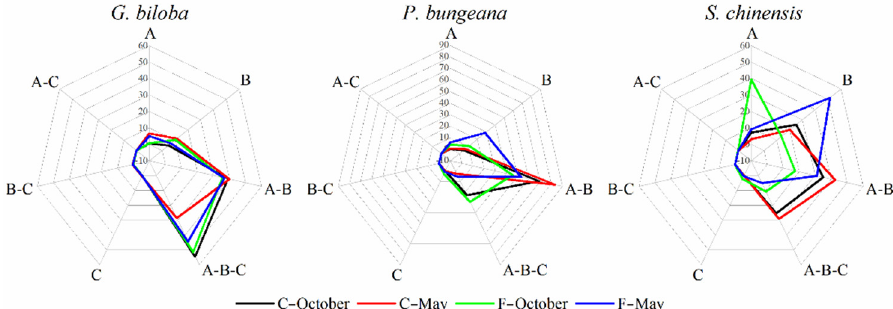
Figure 4. Changes in fungal metabolic function attributes of G. biloba , P. bungeana and S. chinensis in October and May. Letters A, B and C represent the functional attributes of pathotrophs, saprotrophs and symbiotrophs, respectively. C-October, C-May, F-October and F-May represent samples obtained from campus in October, campus in May, forest in October and forest in May.